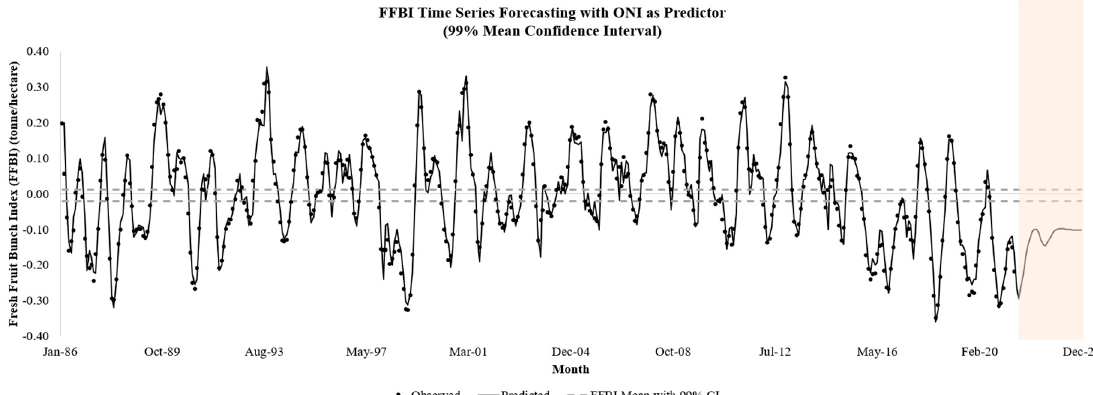
Figure A2. The new FFBI time series, ARIMA (3,1,3) (0,0,1) model with ONI as predictor (adjusted R-squared = 0.9312). Modelled period: February 1986 to June 2021 (N = 425). 30 months forecasted period: July 2021 to December 2023 (N = 30, highlighted area of Figure A2). Note: Dash lines represent BCa 99% confidence interval range of monthly oil palm yield in Malaysia. Unlike FFB model (Figure A1), FFBI model revealed a future monthly under yield concern of Malaysian oil palm industry.